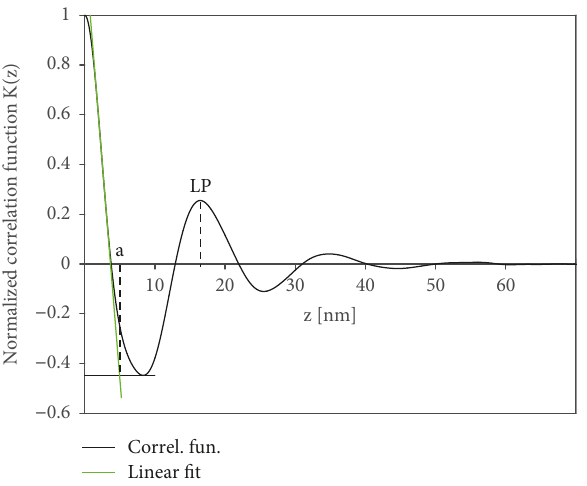
Figure 3: Schematic illustration of the analysis of the WAXD pro fi les including the peak used for the amorphous